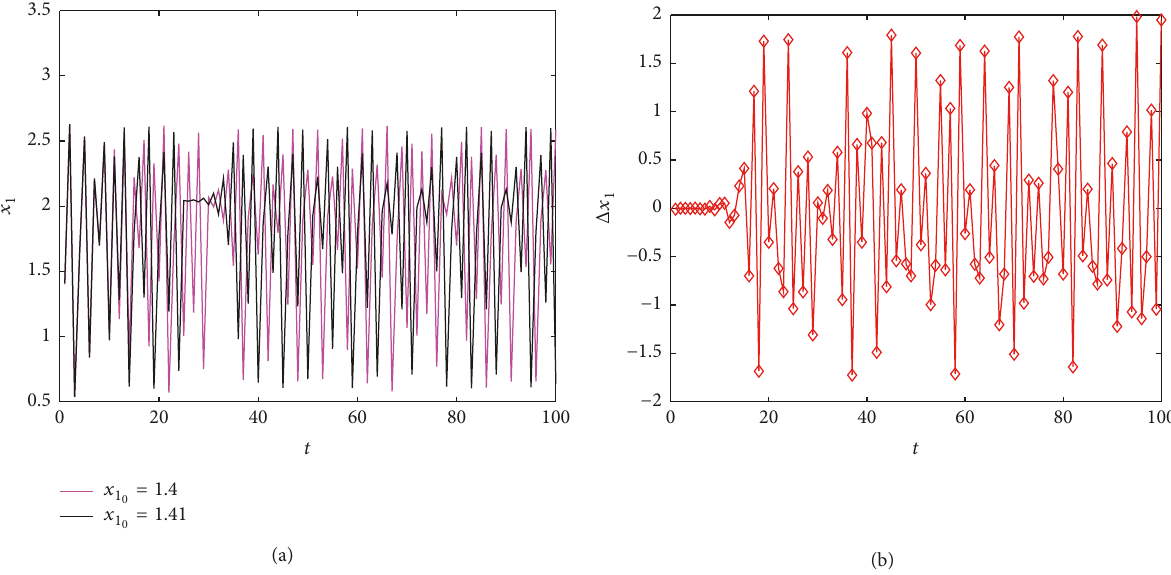
Figure 13: The two orbits and difference of 𝑥 1 -coordinates for initial points (1.4, 1.7) and (1.41, 1.7) and (𝛼 1 = 1.39, 𝛼 2 = 0.36)